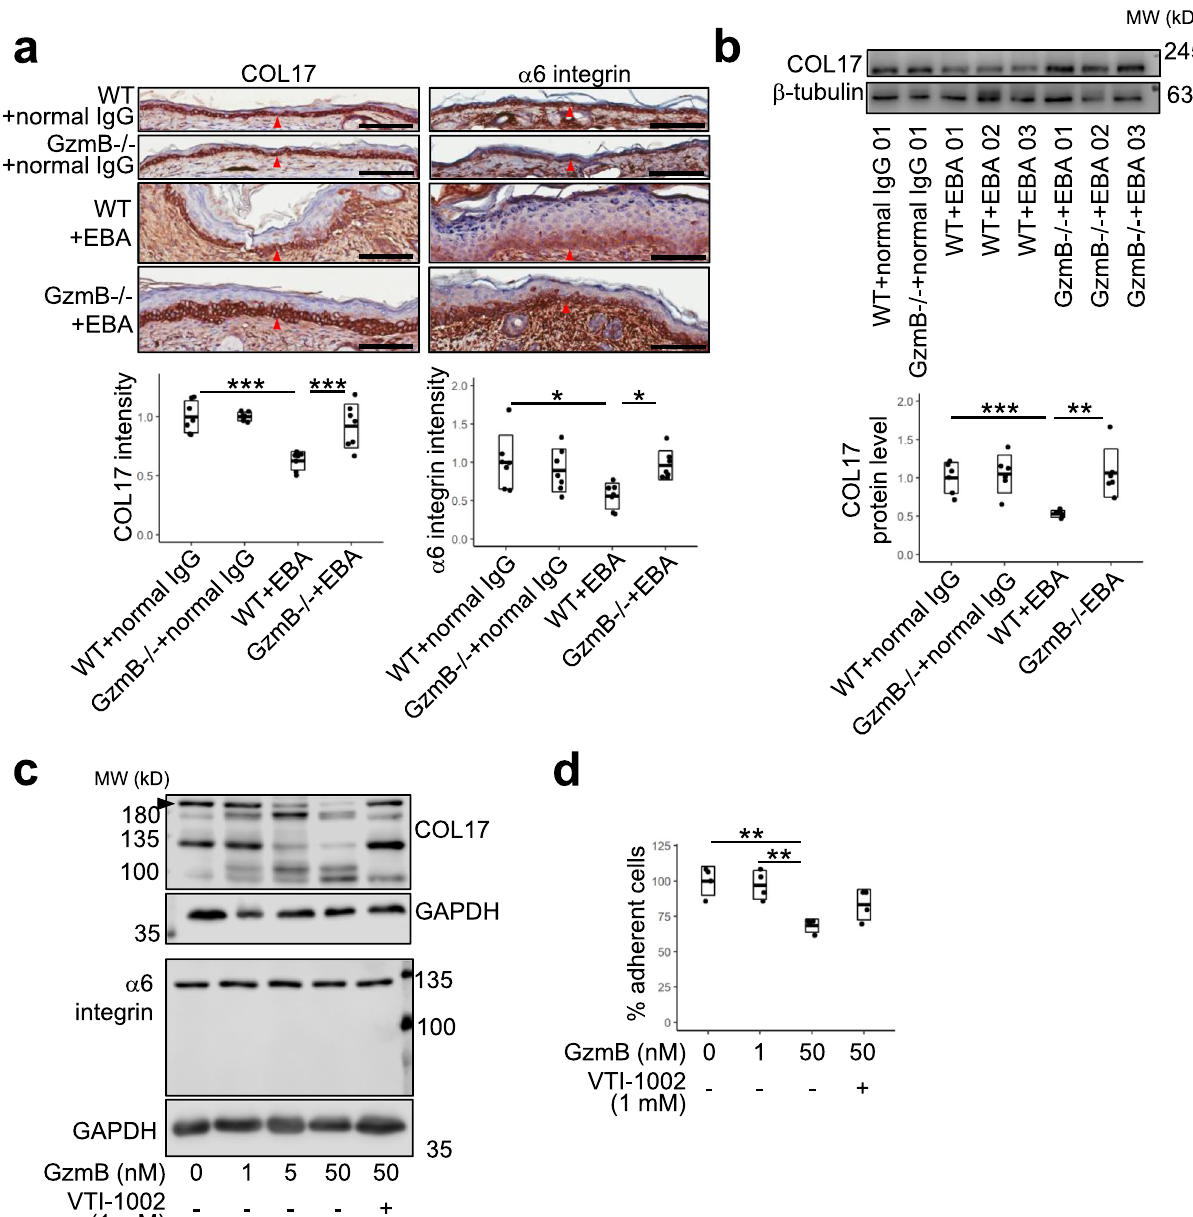
Fig. 2 Granzyme B (GzmB) reduces hemidesmosomal proteins, type XVII collagen (COL17) and α 6 integrin, in an epidermolysis bullosa acquisita (EBA) murine model in vivo and in cultured primary human epidermal keratinocyte (pHEK) in vitro. a Representative COL17 and α 6 integrin immunohistochemistry (IHC) images of ears from both wild-type (WT) and GzmB − / − mice at day 12 with EBA or with injections of normal rabbit IgG. Red arrowheads indicate positively stained areas at dermal – epidermal junction. Scale bar, 100 μ m. Dot plots indicate all individual scores and box plots indicate mean ± standard deviation of the intensity levels of hemidesmosomal proteins in the epidermis de fi ned as (total intensity of hemidesmosomal protein in the epidermis)/(total area of examined epidermis), which were quanti fi ed from IHC images and presented as relative to the mean score of WT with normal IgG injections. N = 7 for each group. b Representative immunoblotting images using an antibody against COL17 for ear extracts from both WT and GzmB − / − mice at day 12 with EBA or with normal IgG injections. Same amounts of the same extracts were loaded on a separate gel and reactivity to β - tubulin antibody was used as sample processing control. Dot plots indicate all individual scores and box plots indicate mean ± standard deviation of COL17 protein levels normalized to the β -tubulin level, which were quanti fi ed from immunoblots and presented relative to the mean score of WT with normal IgG injections. N = 6 for each group. c Representative immunoblotting images using antibodies against COL17 NC16A domain or α 6 integrin with cell lysates of pHEKs, which were incubated with the GzmB inhibitor, VTI-1002- or vehicle-pretreated GzmB for 6 h. Black arrowhead indicates the bands of full-length COL17. Same amounts of the same extracts were loaded on the same or separate gel and glyceraldehyde 3-phosphate dehydrogenase (GAPDH) served as sample processing control. Molecular weight (MW) is indicated in the sides. Images are representative of three independent experiments. d pHEKs were incubated with VTI-1002- or vehicle-pretreated GzmB for 6 h followed by trypsinization for 7 min at 37 °C and the attached cells were counted. Cell numbers were normalized to the average number of attached cells incubated without GzmB or VTI-1002. Dot plots indicate all individual scores and box plots indicate mean ± standard deviation. N = 4 for each group. In all plots, * P < 0.05, ** P < 0.01, *** P < 0.001 (one-way ANOVA followed by Tukey ’ s multiple